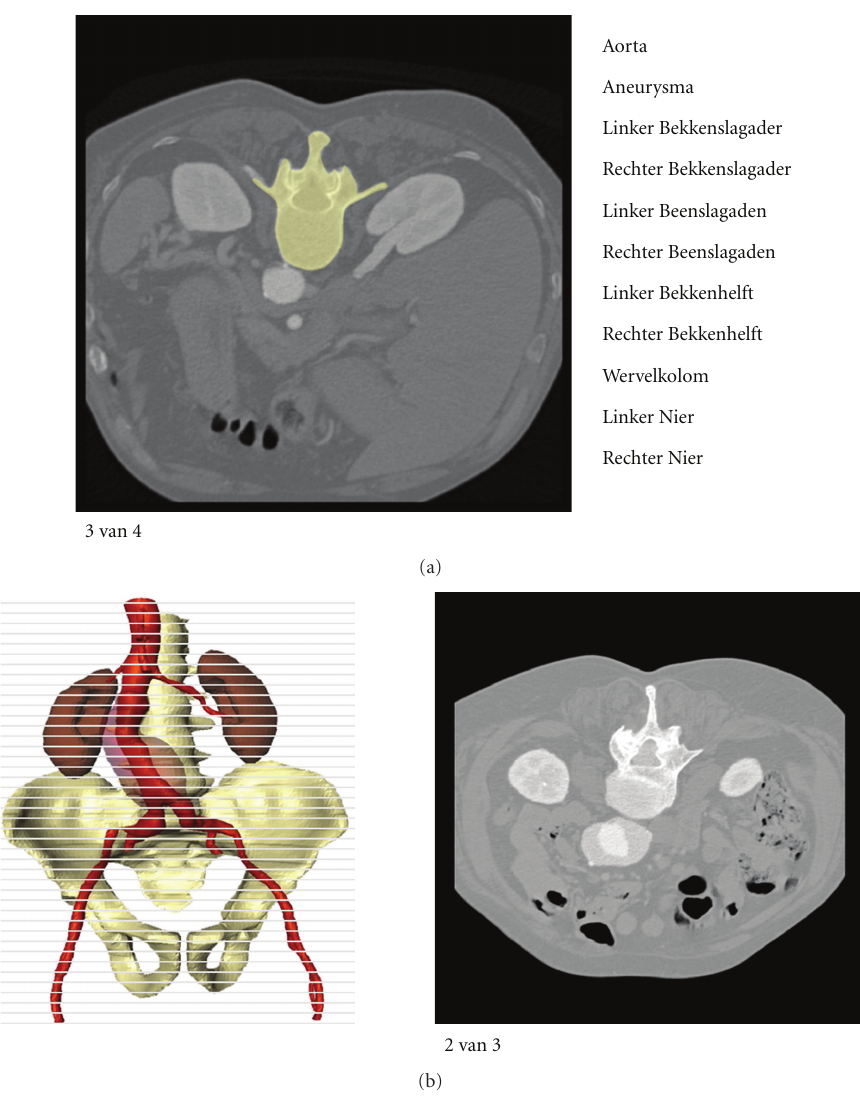
Figure 2: Screenshots of an item of each of the two tests. (a)the identification test with the eleven possible names of the highlighted structure, and (b) the localization test that involved selecting the level in the left image from which the right image was